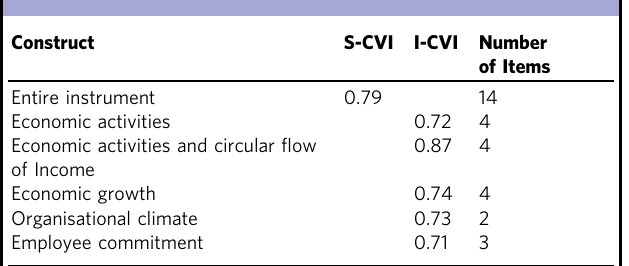
Table 1 Validity tests.